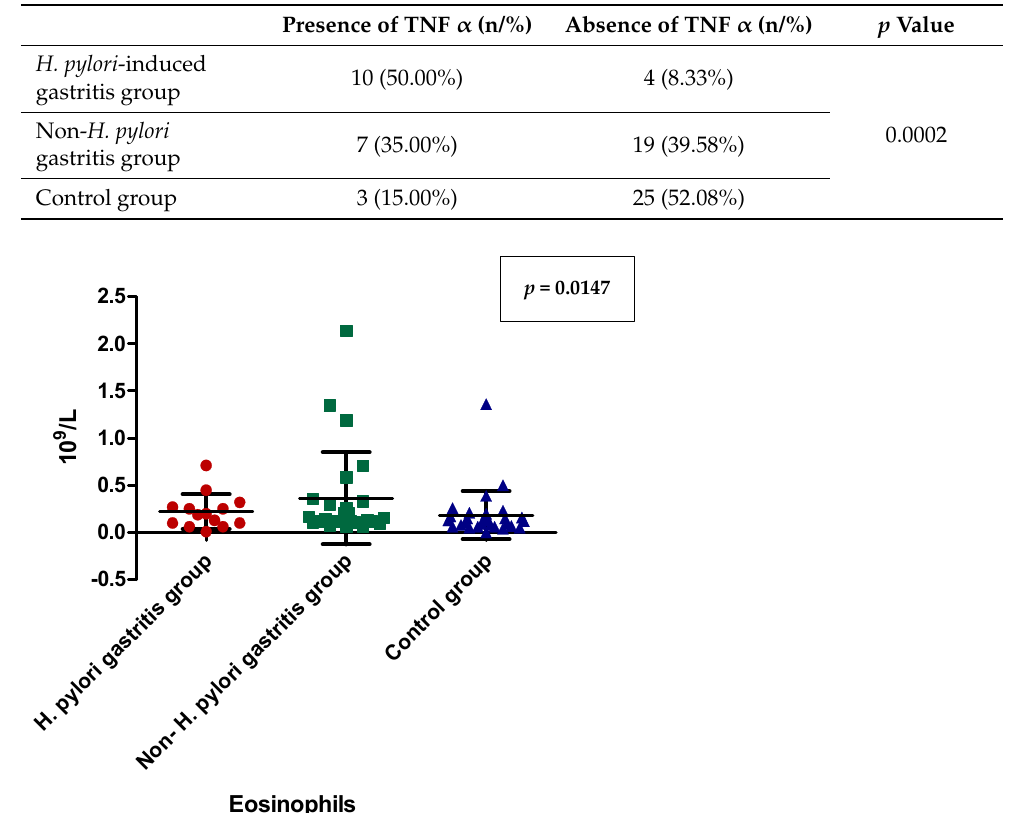
Figure 4. The difference of median values of eosinophils between the three groups.